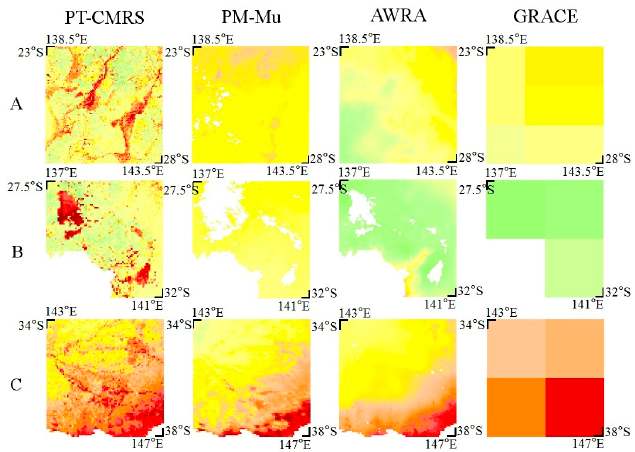
Figure 3. Zoom in mean annual ET values from the four models over three smaller regions (boxes A, B, and C shown in Figure 2) that are prone to inundation or irrigation.